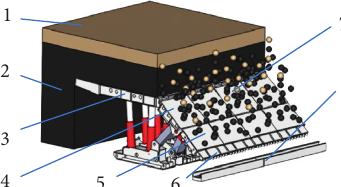
Figure 1: Top coal caving. 1. Coal-gangue mixture seam; 2. Thick seam; 3. Top beam; 4. Shield beam; 5. Tail beam; 6. Poling plate; 7. Coal guage particles; 8. Scraper